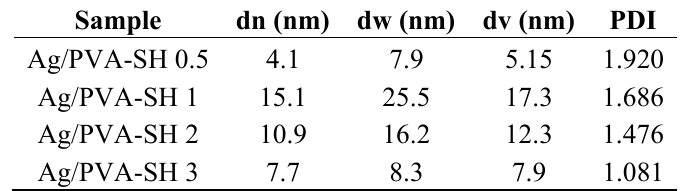
Table 1. Average particle size diameters and polydispersity indices (PDI) obtained from the particle size distribution based on TEM of the Ag NP capped with PVA-SH.